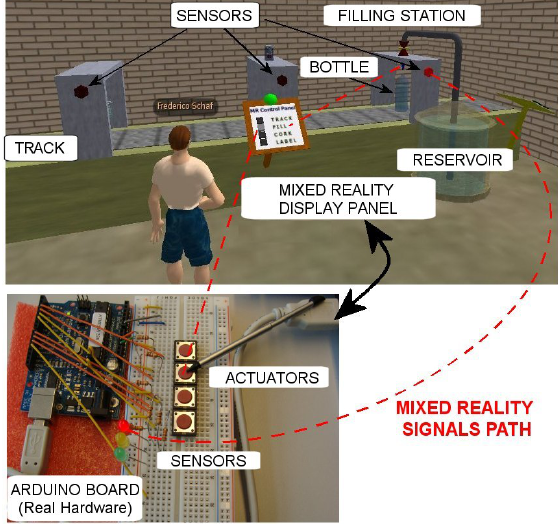
Figure 5. Hardware-in-the-Loop scheme with Arduino and the Virtual Bottling Plant